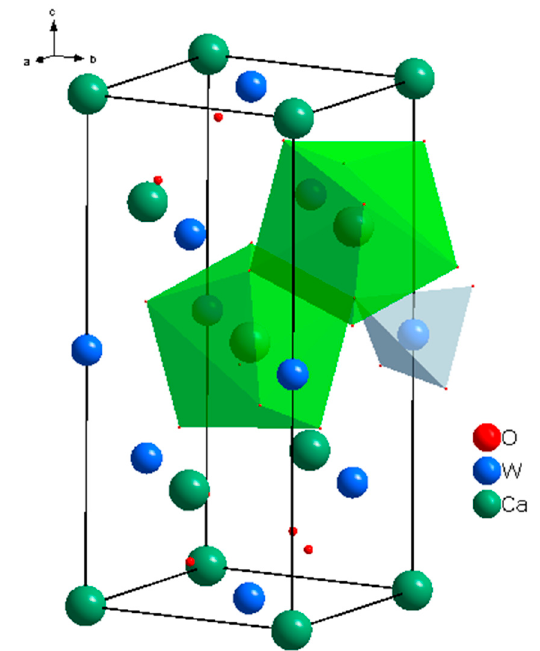
Figure 1. Crystal structure of scheelite CaWO 4 .